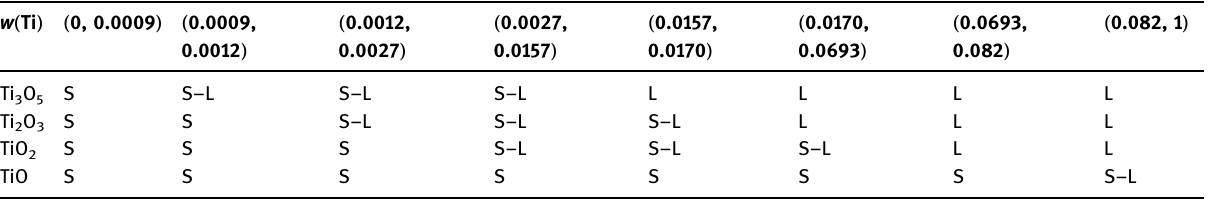
Table 8: Precipitation time of Ti – O compounds in steel when without considering the effect of element segregation ( S: solid; L: liquid; S – L: solid – liquid phases; 0.082 was the critical Ti concentration of TiO at the solid phase line ) w ( Ti ) ( 0, 0.0009 ) ( 0.0009,